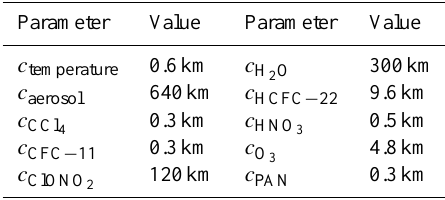
Table A1. Correlation lengths employed for the